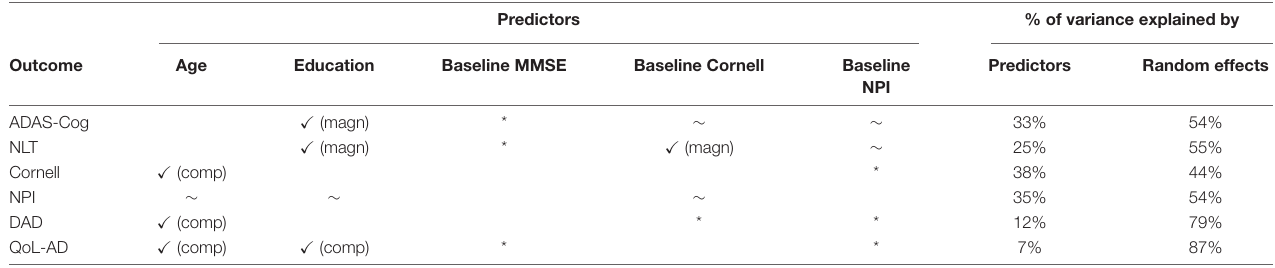
TABLE 1 | Summary of the assessment session X individual characteristics interactions, and main effects for each of the outcome measures considered, with the % of variance explained by predictors and random effects (subjects and centers). Predictors % of variance explained